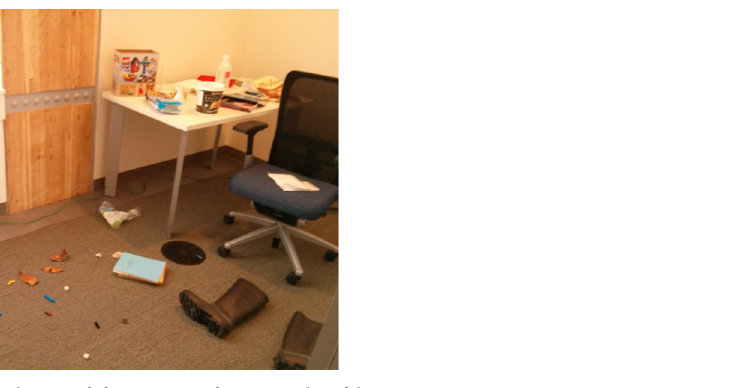
(Table 1) for a total of 18 test items. Aside from the test items, there were other items to be organized as well, such as textbooks, boots, a cardigan etc., to convince participants of the orga- nization task. The arrangement of the items in the room was consistent between buildings, with items being placed in logical locations in the rooms (e.g. spoons were placed in food con- tainers, leaves were placed on the ground). A container, organics, and garbage receptacle was located in the hallway next to the door into the office room (Fig 2). These receptacles are used throughout the university campus. Participants wore a pair of glasses with a video recorder (720P HD Camera Eyewear) during the experimental task as a deception to draw participants away from the true purpose of the study. A hidden Logitech webcam was used to film the par- ticipants at the receptacles.